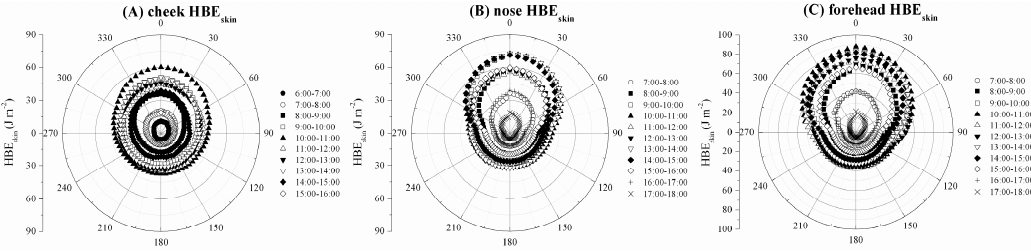
Figure 6. 1 h cumulative HBE skin changes with rotation angles: ( A ) cheek, ( B ) nose, and ( C ) forehead.